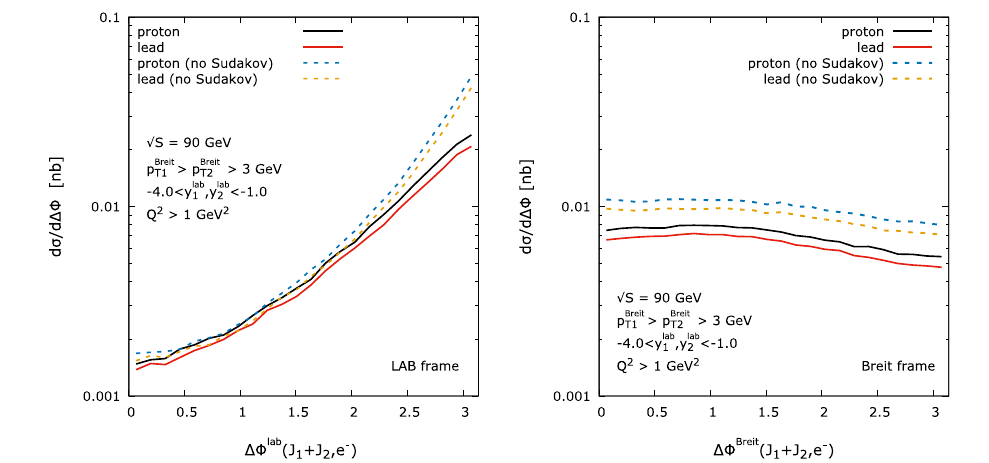
Fig. 4 Azimuthal correlations between the total transverse momen- tum of the dijet system and the transverse momentum of the scattered electron at EIC in two frames: the LAB frame (left), the Breit frame